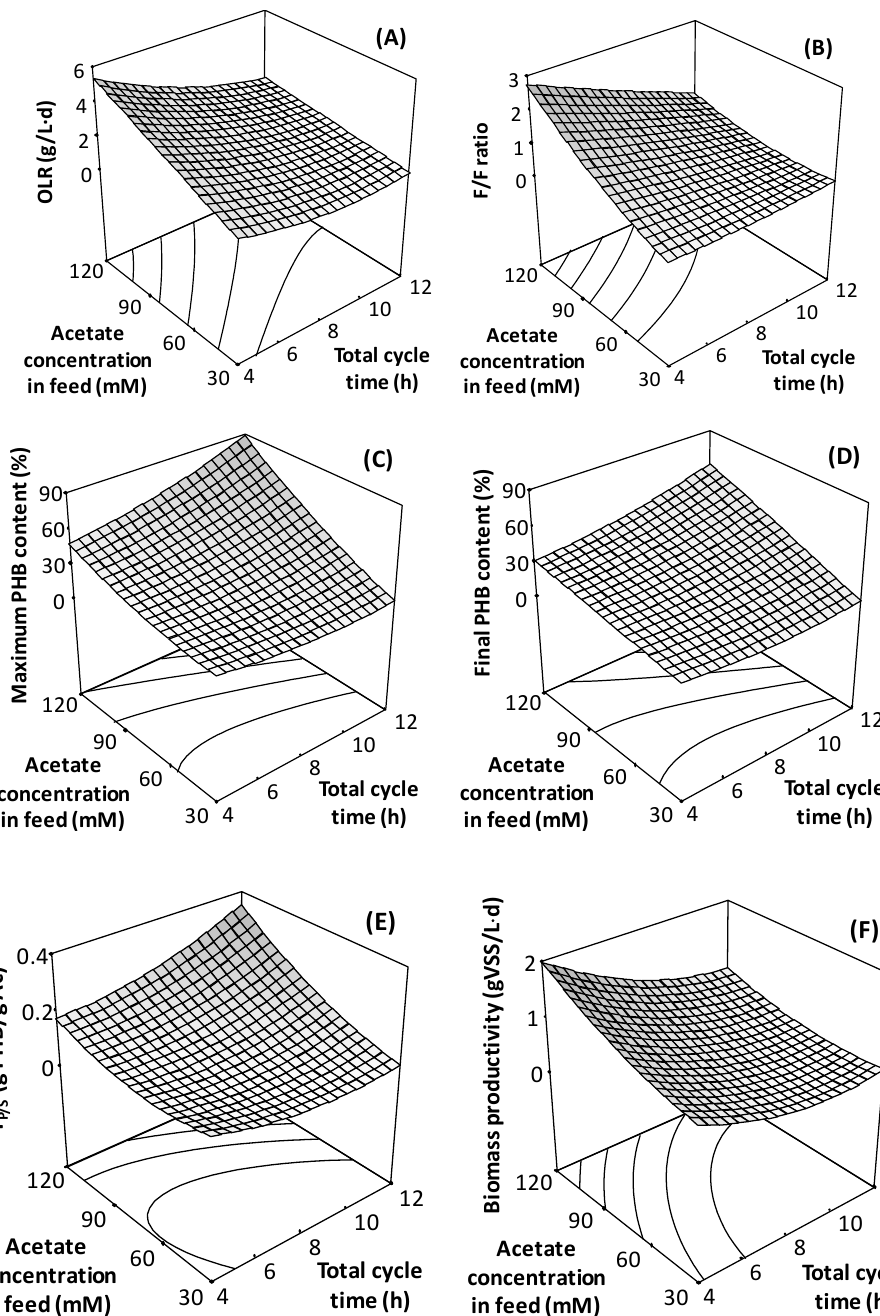
Figure 3. Selected responses observed during surface response methodology. Factors tested: Acetate concentration in the feed and total cycle time. Responses: ( A ) OLR, ( B ) F/F ratio, ( C ) maximum PHB content of biomass, ( D ) PHB content of biomass by the end of the cycle, ( E ) yield PHA/acetic acid, ( F ) biomass productivity.